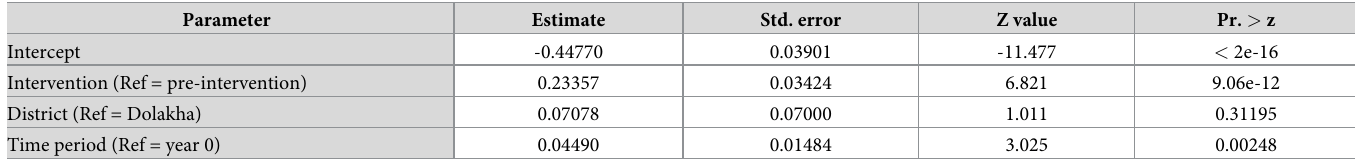
Table 2. Generalized linear mixed model fit by maximum likelihood (laplace approximation) fixed effects (raw estimates).